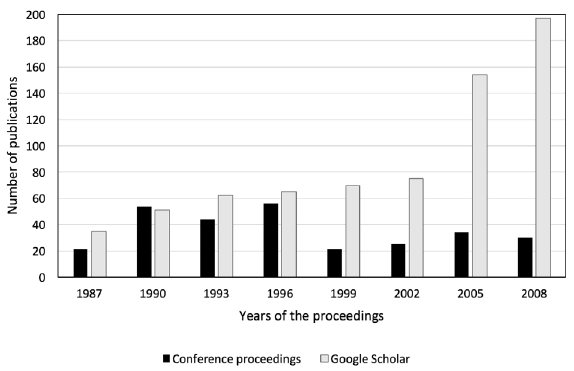
Figure 1. Total number of publications from each international cycad conference proceeding and from a Google Scholar search using the three years prior to each proceedings year as simultaneous publications for each